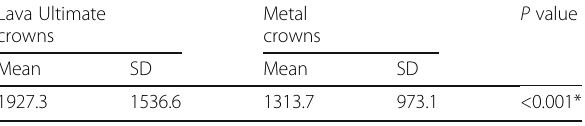
Table 3 Descriptive statistics and results of comparison between microstrains induced by the two crown materials regardless of other variables (collective microstrains)